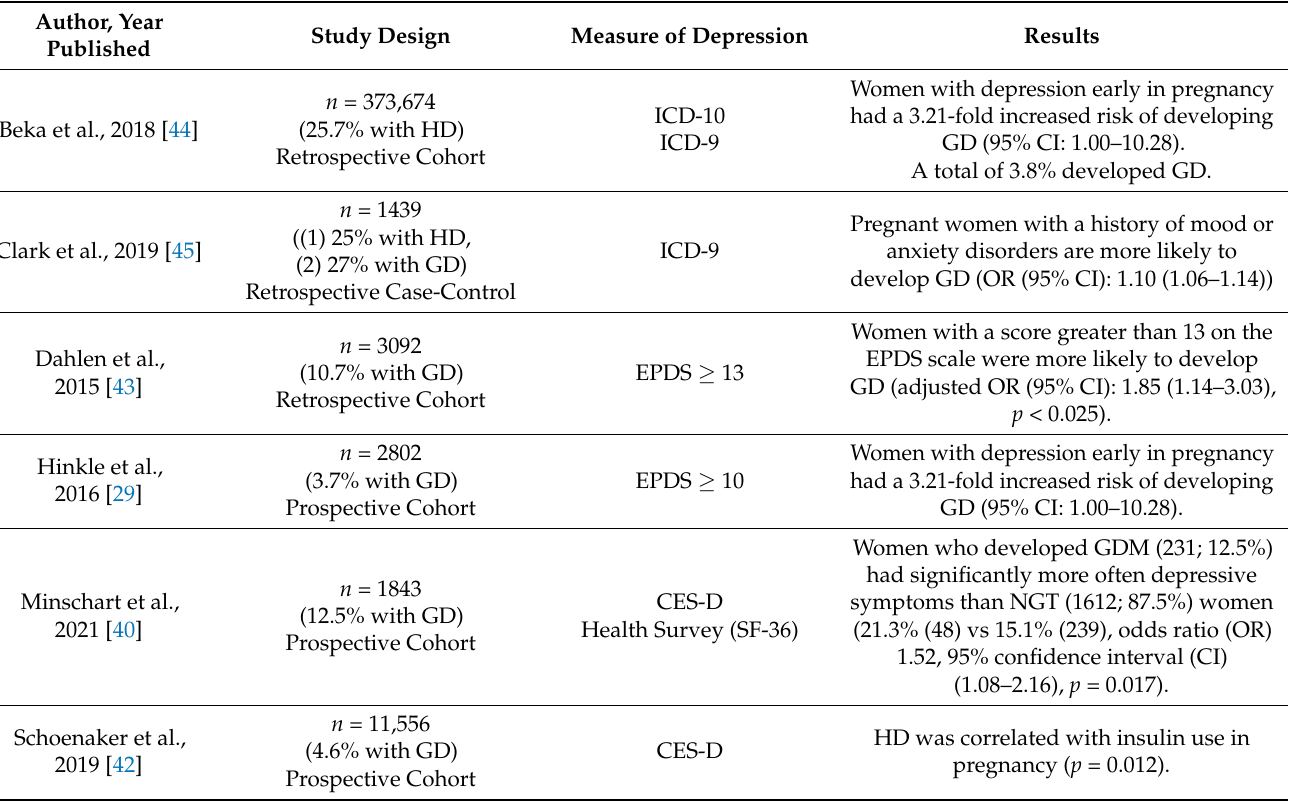
Table 1. Outcomes of studies evaluating the impact of history of depression in women with gestational diabetes.